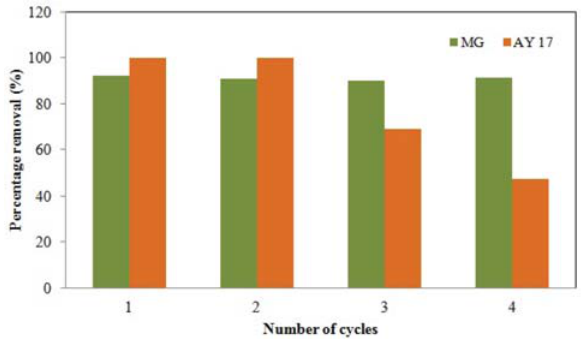
Figure 15. Effect of reusability in the removal of MG and AY 17